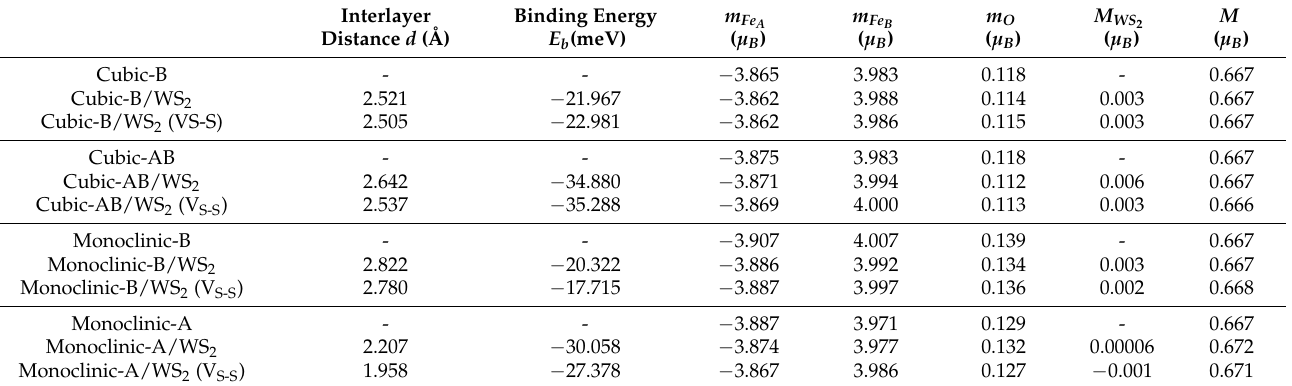
Table 1. Basic properties of the considered heterostructures and standalone Fe 3 O 4 layers with cubic- B, cubic-AB, monoclinic-B, and monoclinic-B surface terminations. The interlayer distance d (Å), (cid:16) (cid:17) E HST − ∑ i E layer / N ( E HST is the total energy of the heterostructure, E layer binding energy E b = i the total energy of the ith isolated layer, N is the number of atoms in the supercell), average magnetic moments for the inequivalent atoms of Fe 3 O 4 m Fe , m Fe , m O , the total magnetization per atom of B A the WS 2 monolayer M WS , and total magnetization per atom of the entire structure M (all magnetic 2 properties are in ( µ B ) units) are